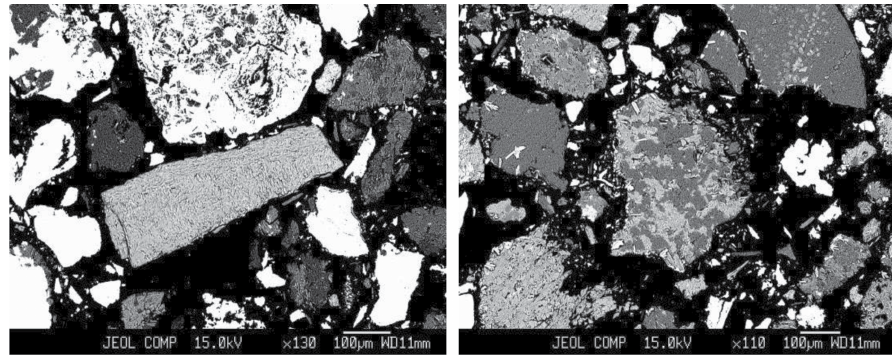
Figure 2: Electron probe photographs of the minerals.